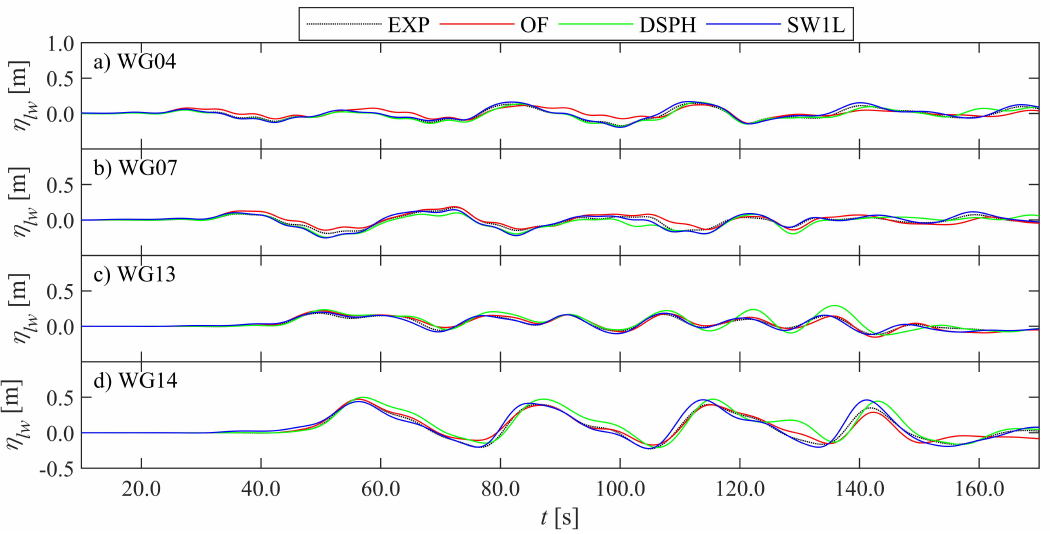
Figure 5. Comparison of the η LW time series at selected sensor locations ( a – d ). The zero-reference is the SWL. Adapted from the work in [3], with permission from the authors, 2020.